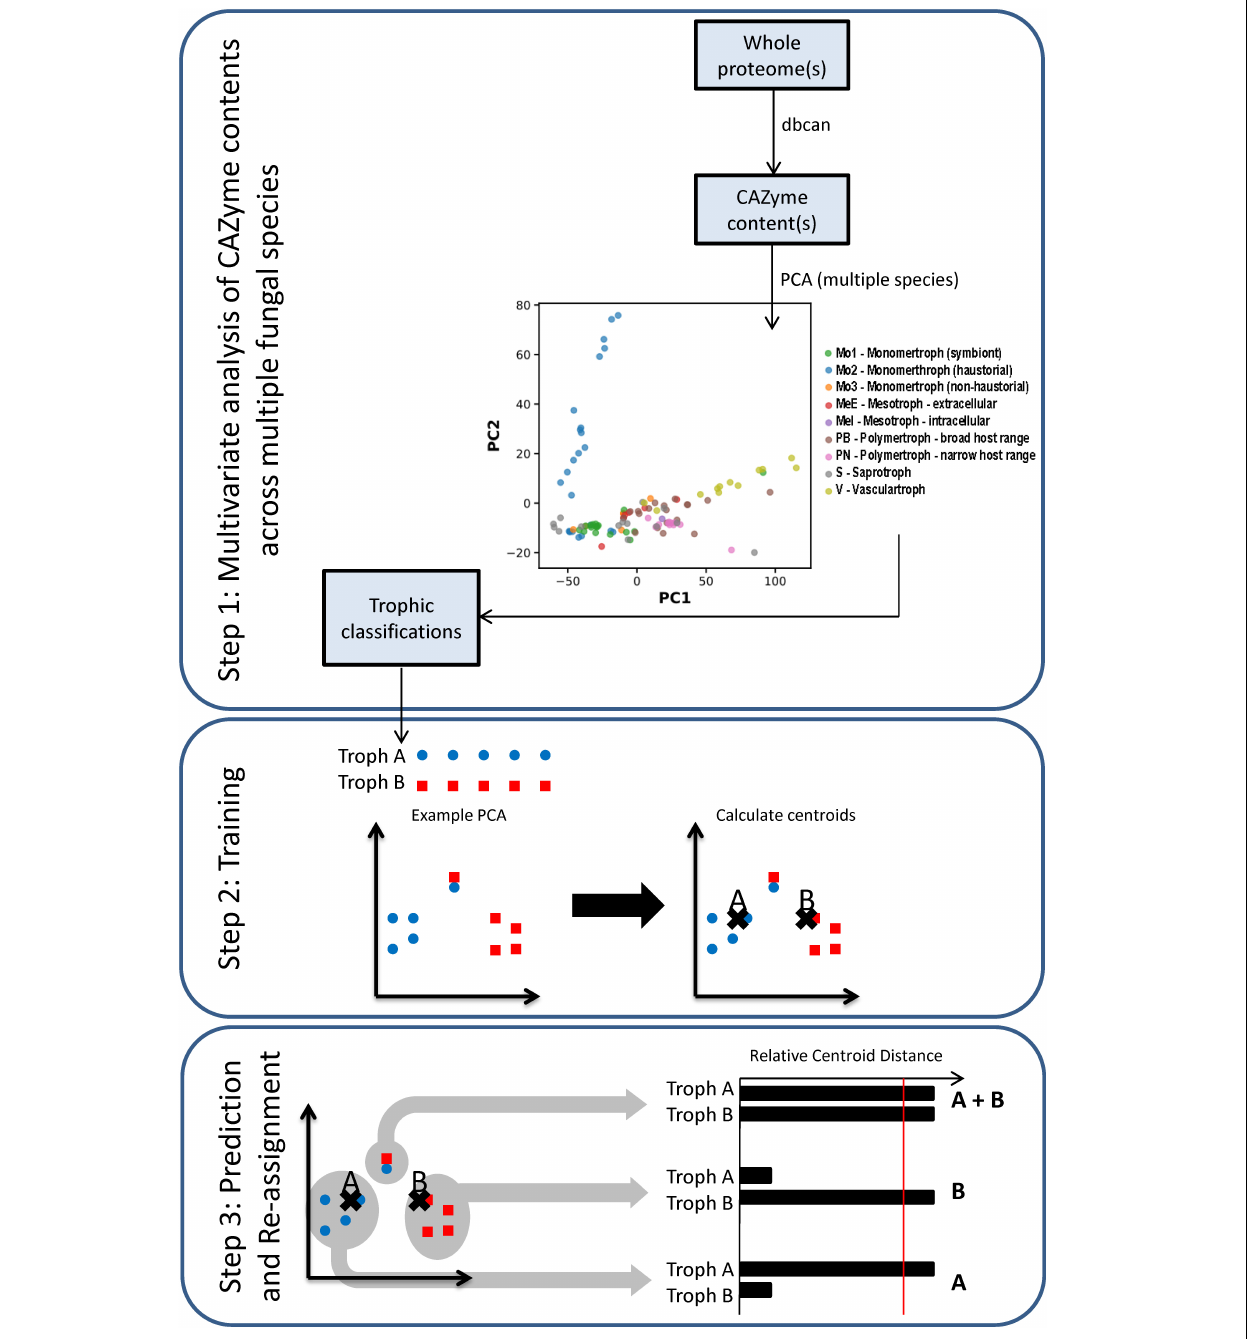
FIGURE 2 | Workflow of the trophic prediction method. Step 1: CAZyme gene contents are compared across species using multivariate analysis. Step 2: trophic classifications are assigned to each species ( Supplementary Data Sheet S1 ) and centroids are calculated for each trophic class. Step 3: relative centroid distances (RCDs) are calculated for each species, with the closest centroid assigned an RCD score of 1, the furthest as 0, and other centroid distances expressed as a relative proportion. Species were predicted as members of a major trophic class where RCD = 1 and assigned additional affinities for other classes or sub-classes where RCD ≥ 0.95. Importantly, species may be predicted after RCD calculation into a different class than was initially